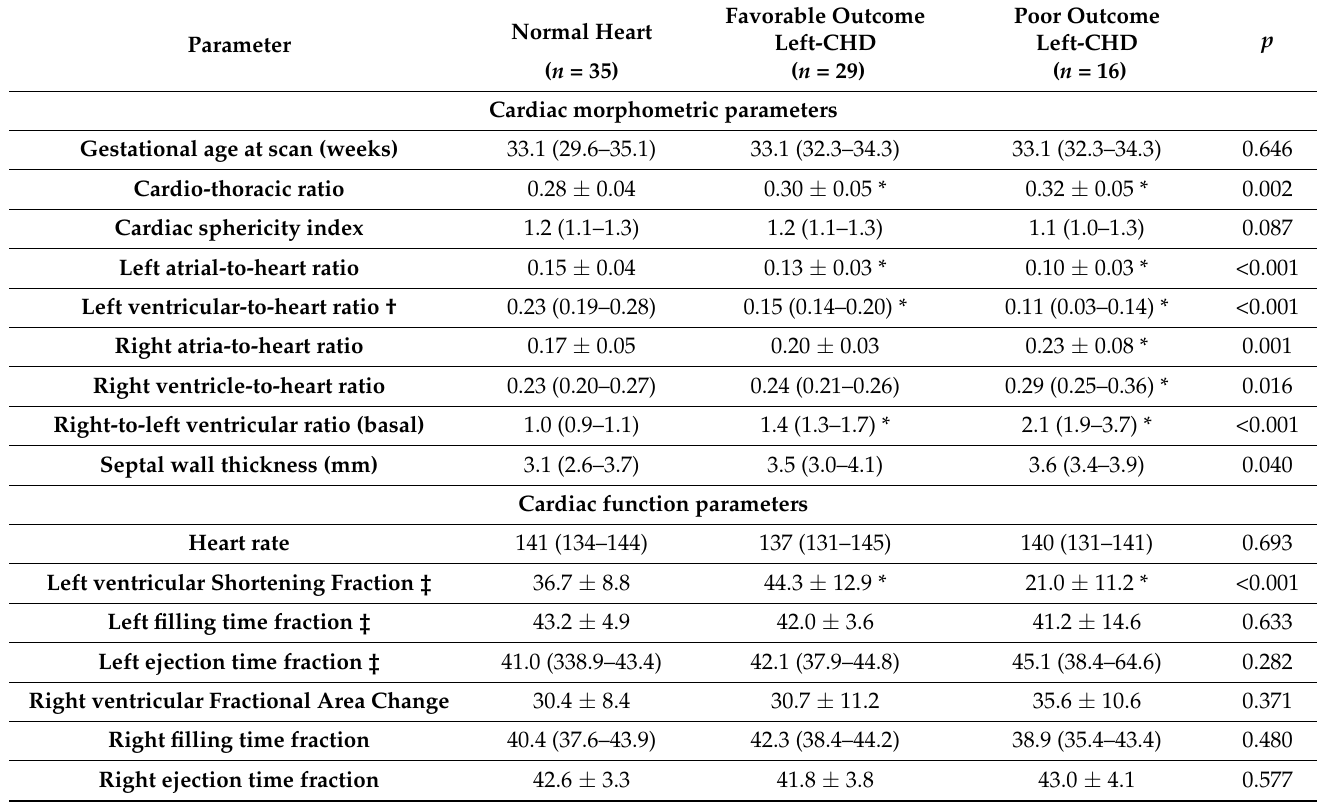
Table 2. Fetal echocardiographic results in the study